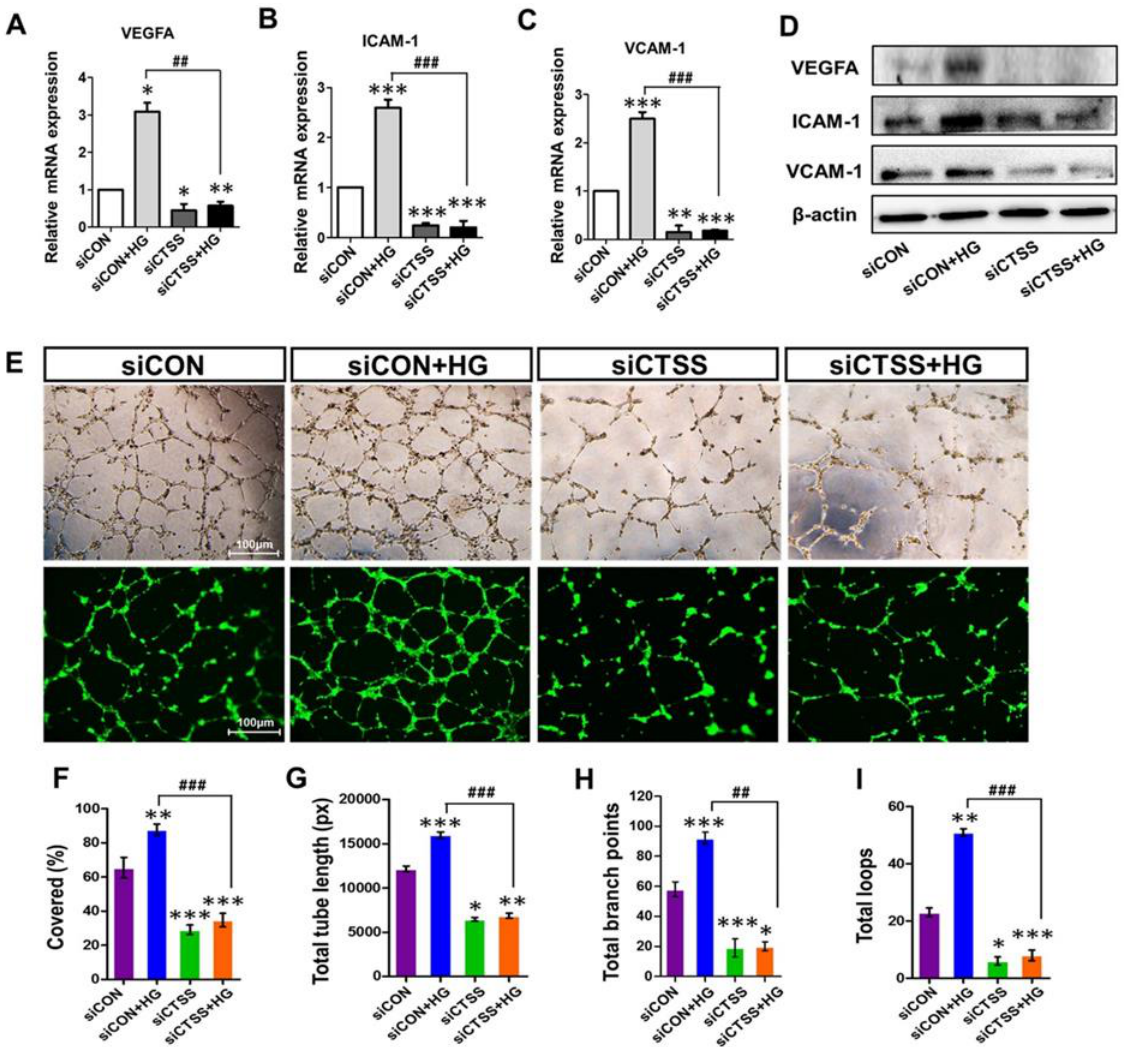
Figure 3. Expression of vascular endothelial growth factor A (VEGFA) and adhesion molecules ICAM-1 and VCAM-1, as well as the tube formation ability of cathepsin S (CTSS) siRNA-transfected HUVEC cells post-treatment with 30 mM high glucose. ( A – D ) mRNA and protein expression of VEGFA, ICAM-1, and VCAM-1. ( E ) Phase-contrast images of tube formation in HUVECs and fluorescence images of tube formation captured after calcein AM staining. Increased tube formation was observed in siCON + HG samples compared to siCTSS + HG samples. ( F ) Percentage covered area (%), ( G ) total tube length (measured in pixels, px), ( H ) number of branching points, and ( I ) number of total loops of tube formation were obtained by ImageJ densitometry. Values are expressed as mean ± SEM ( n = 3 biological replicates per group). p ≤ 0.05 indicates statistical significance. * p < 0.05, ** p < 0.01, *** p < 0.001 versus control samples; ## p < 0.01, ### p < 0.001 versus HG-treated samples.